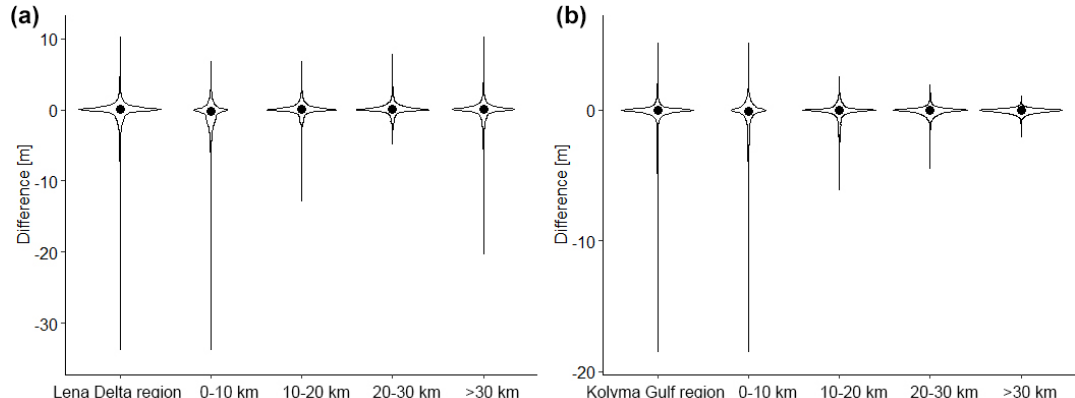
Figure F1. The difference in the Topo to Raster (TTR 200 ) and IBCAO v4 bathymetry (Jakobsson et al., 2020) shown in relation to distance from the shore in violin plots. The plots are based on the difference (TTR 200 − IBCAO v4) layers, where negative values indicate that the IBCAO v4 underestimates the depth compared to the TTR 200 , and positive values indicate an overestimation of the depth by the IBCAO v4 in comparison to the TTR 200 bathymetry. The y axis shows the absolute difference between the two bathymetrical products. Black dots show the median value. Areas where the IBCAO v4 bathymetry shows values above mean sea level were excluded from this analysis (see purple areas in Figs. 8 and 9 in the main text). Panel (a) shows plots of the Lena Delta region. The first plot to the left includes the entire Lena Delta region, whereas the other four plots show areas at certain distances from the coast (0–10, 10–20, 20–30, and > 30km away from the shore). Panel (b) shows plots of the Kolyma Gulf region. The first plot to the left includes the entire Kolyma Gulf region, whereas the other plots represent areas with certain distances from the coast (0–10, 10–20, 20–30, and > 30km away from the shore). Please note the different scales of the y axes. The TTR 200 − IBCAO v4 difference shows that, particularly in the coastal zones and near-shore areas, the IBCAO underestimates the depth by not capturing the small-scale variability. In contrast, the TTR 200 bathymetry detects the continuation of the Lena and Kolyma main channels from the river mouth into offshore